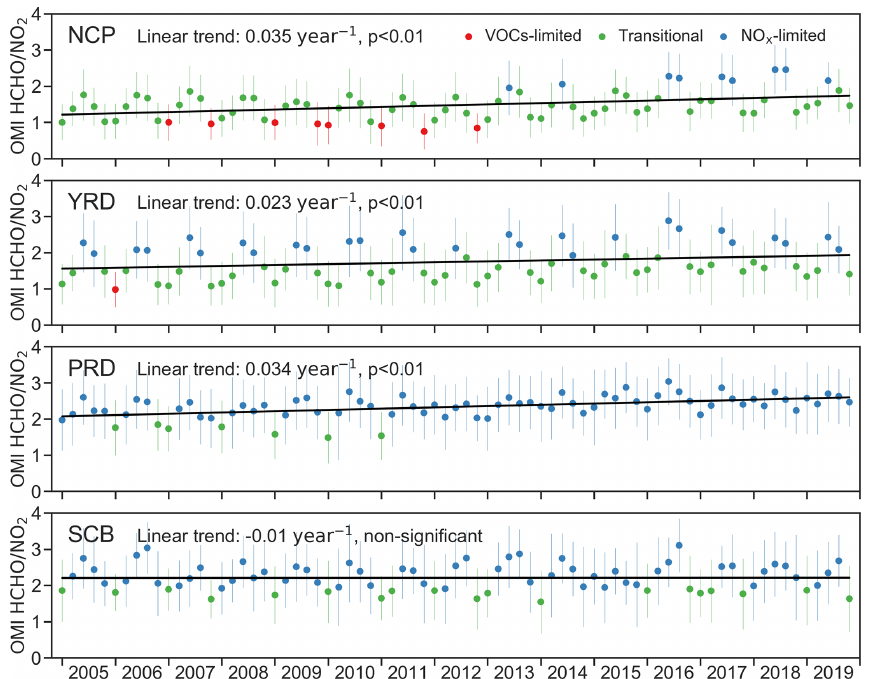
Figure 9. The time series of HCHO / NO 2 in the four megacity clusters from 2005 to 2019. Black lines indicate the linear trend of HCHO / NO 2 . Red, green, and blue dots stand for VOC-limited, transitional, and NO x -limited regimes,